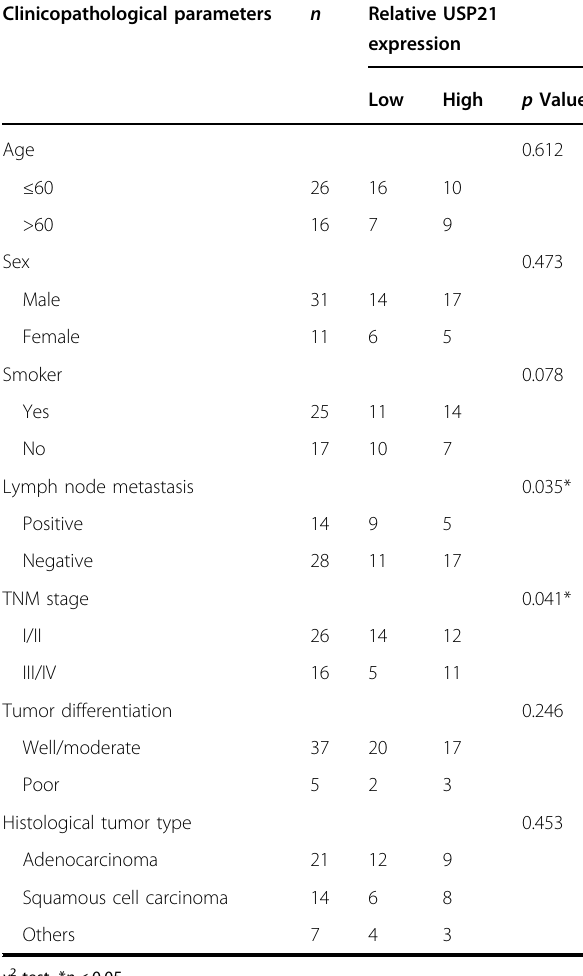
Table 1 Correlation between USP21 expression and clinicopathological parameters of NSCLC patients ( n = 42). Clinicopathological